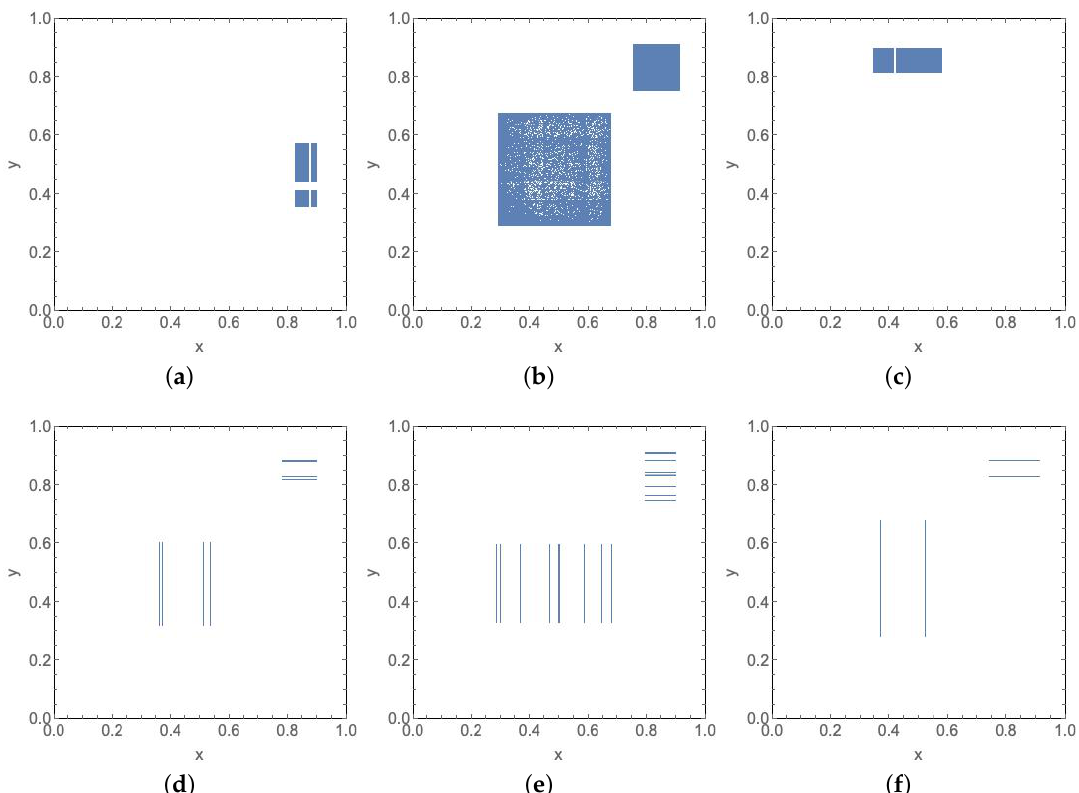
Figure 19. ω -limit sets for Kopel’s model for λ 1 = λ 2 = 1. We have computed orbits or length equal to 200000 and we have plotted the last 100000. ( x 0 , y 0 ) are the initial conditions. The parameter values for each figure follows. ( a ) µ 1 = 3.6, µ 2 = 3.95, x 0 = 0.539815 and y 0 = 0.933646; ( b ) µ 1 = 3.65, µ 2 = 3.65, x 0 = 0.539815, y 0 = 0.933646; ( c ) µ 1 = 3.85, µ = 3.6, x 0 = 0.539815, y 0 = 0.933646; ( d ) µ 1 = 3.6, µ 2 = 3.55, x 0 = 0.539815, y 0 = 0.933646; ( e ) µ 1 = 3.6, µ 2 = 3.65, x 0 = 0.539815 and y 0 = 0.933646; ( f ) µ 1 = 3.65, µ 2 = 3.55, x 0 = 0.539815, y 0 =